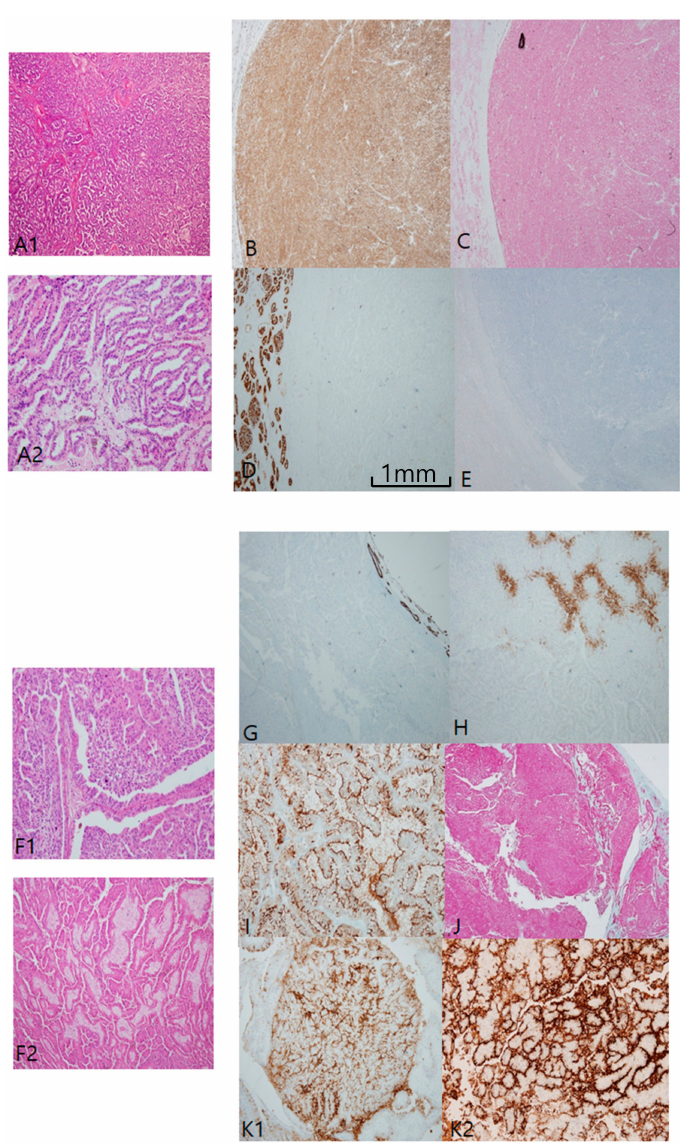
Figure 2. Papillary renal cell carcinoma (PRCC), type I. ( A1 , A2 ) Uniform structure predominantly composed of small slit-like tubules and luminal branched papillae is a characteristic of PRCC, type I. ( B – E ) PRCC type I is characteristically cytokeratin 7 (CK7) ++ ( B ) / Alpha-methylacyl-CoA racemase (AMACR) ++ ( C ) / CD10 − ( D ) / carbonic anhydrase IX (CAIX) − ( E ). PRCC, type II. ( F1 , F2 ) PRCC type II di ff ers from type I in larger and more complicated papillae line by taller larger cells. Aggregates of foamy histiocytes in the stroma of papillae are frequently noted. ( G – K ) Immunohistochemical (IHC) characteristic of PRCC, type II. PRCC, type II is usually CK7 negative ( G ), CAIX negative ( H ), epithelial membrane antigen + ( I ) AMACR ++ ( J ), and CD10 ++ ( K1 , K2 ). CD10 is basally distributed with a central sparing clubbing pattern ( K2 ). Scale bars = 1